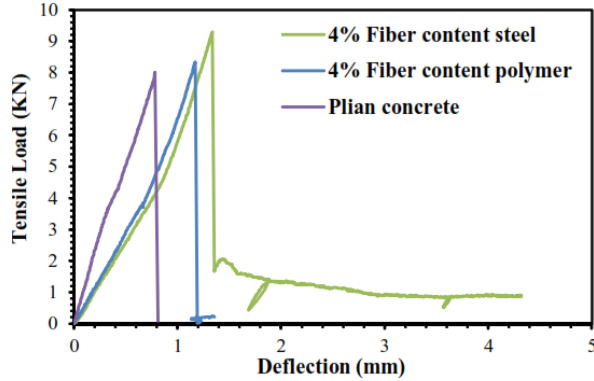
Figure 8: Average tensile load-deflection curves of the tested speci- mens a) SFRC specimens; b) PFRC